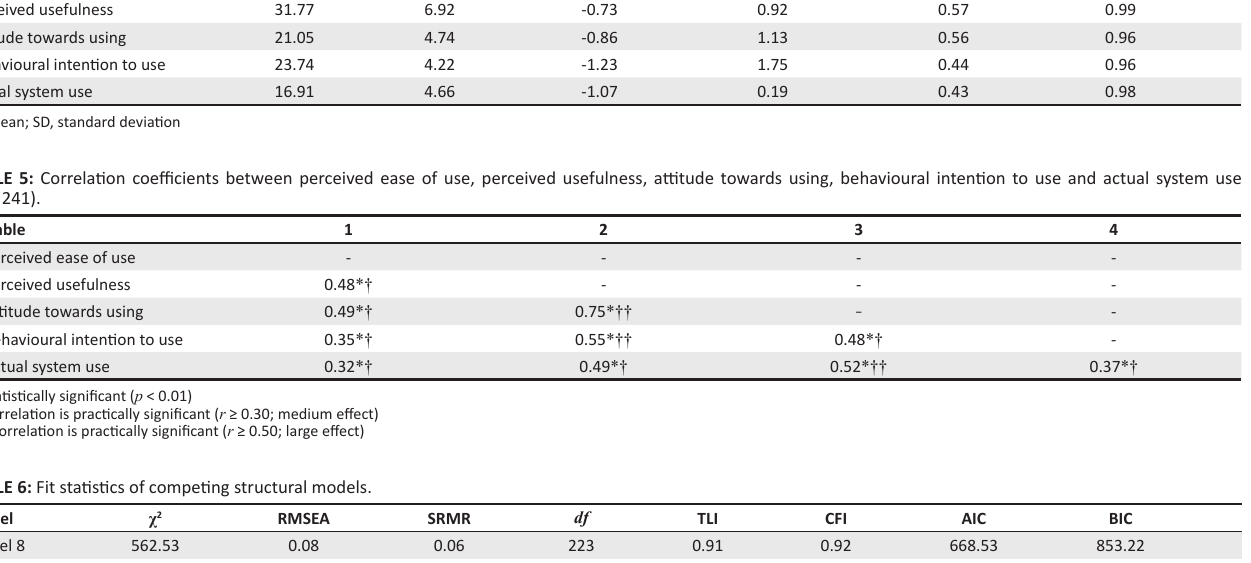
TABLE 4: Descriptive statistics, reliability coefficients and correlation means coefficients and inter-item correlation coefficients of the TAM measuring instruments ( N = 241). Measure M SD Skewness Kurtosis Inter-item r ρ Perceived ease of use